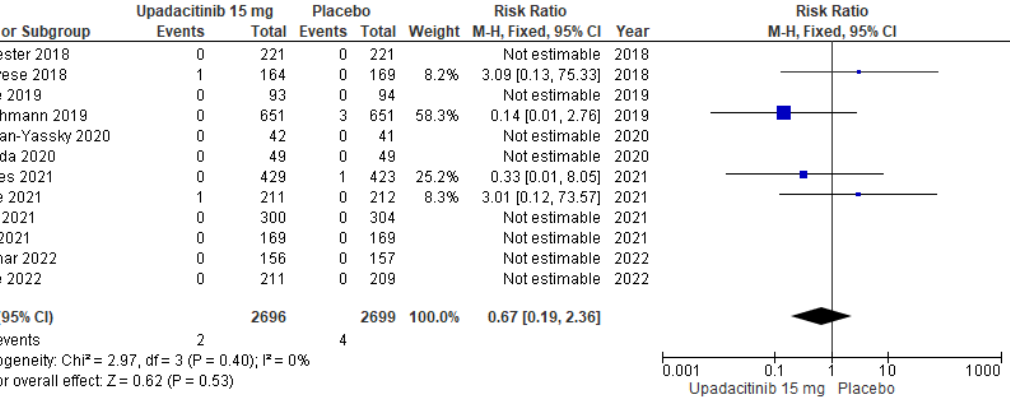
Figure 5. Forest plot of the comparison: upadacitinib 15 mg vs. placebo. Outcome: MACE (major adverse cardiovascular events) [11 – 17,20 – 26].